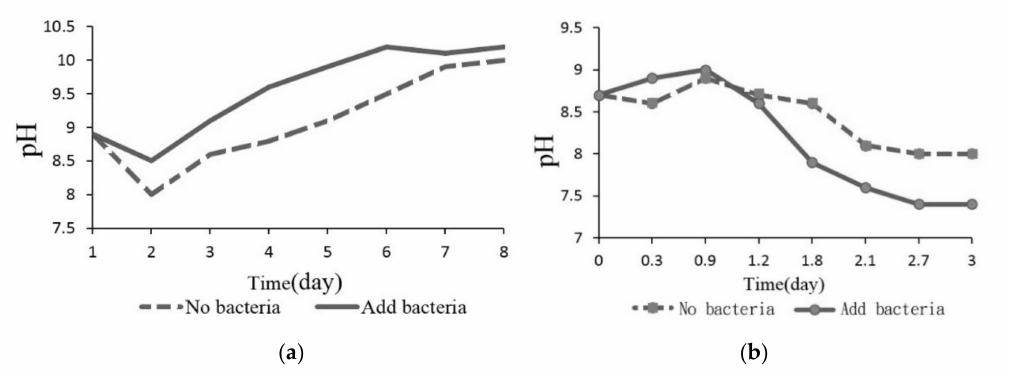
Figure 12. pH data diagram for ( a ) traditional fermentation and ( b ) solar fermentation.